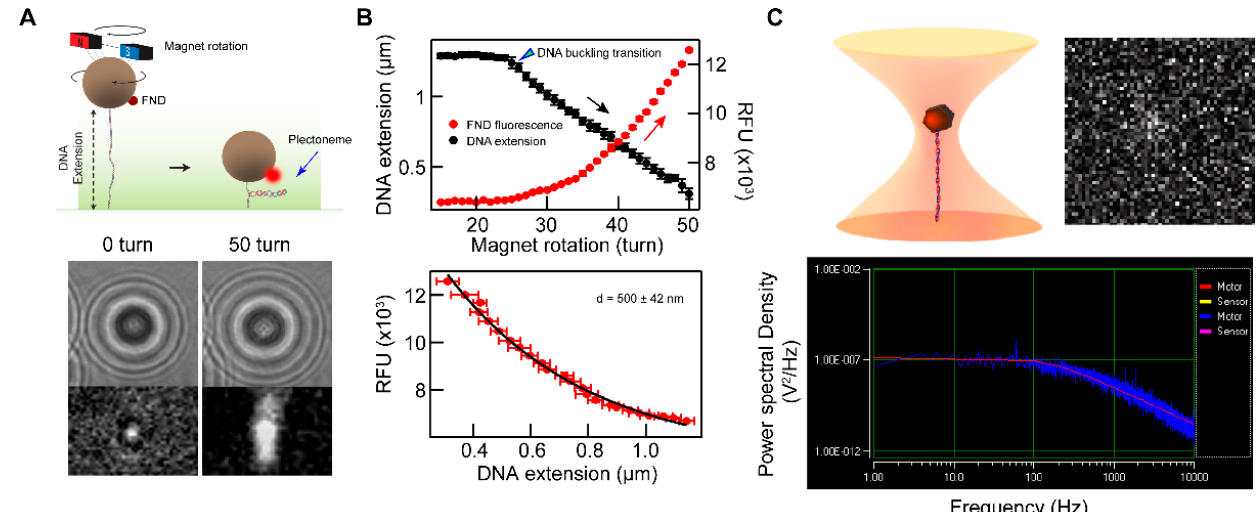
Figure 5. Single molecule applications of FND-biotin. ( A ) Cartoon of TIRF depth calibration using magnetic tweezers (top); Bright field images of a magnetic particle from which the height of the particle can be determined with nm accuracy (middle); fluorescent images of an ND–biotin attached to a magnetic particle (bottom) at two different magnetic rotations. ( B ) DNA extension and fluorescence intensity (RFU) were simultaneously measured for increasing magnet rotations. After the DNA buckles and forms a plectoneme, the DNA extension (bead height) linearly decreases, while the fluorescent intensity increases exponentially (top); RFU plotted as a function of DNA extension and fitted with a single exponential to acquire the characteristic TIRF depth, d . ( C ) Optical trapping of a DNA tethered ND–biotin particle (top, left) and a fluorescence image (a single 40 ms exposure from Supplemental Video S1) of a trapped FND that is visible due to two–photon excitation by the CW 1064 nm trapping laser (top, right); Power spectral density of the ND–biotin displacement relative to a trap center fit with a Lorentzian to determine the trap stiffness (bottom).